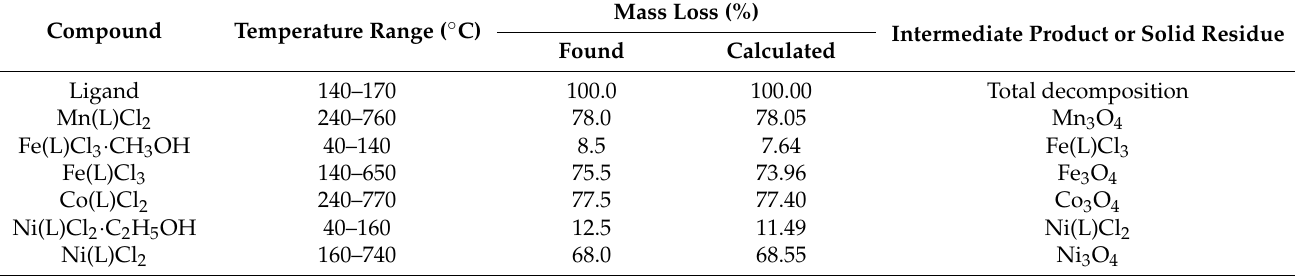
Table 3. Thermal decomposition data calculated or derived from decomposition patterns of the free ligand and its Mn(II), Fe(III), Co(II) and Ni(II) complexes.